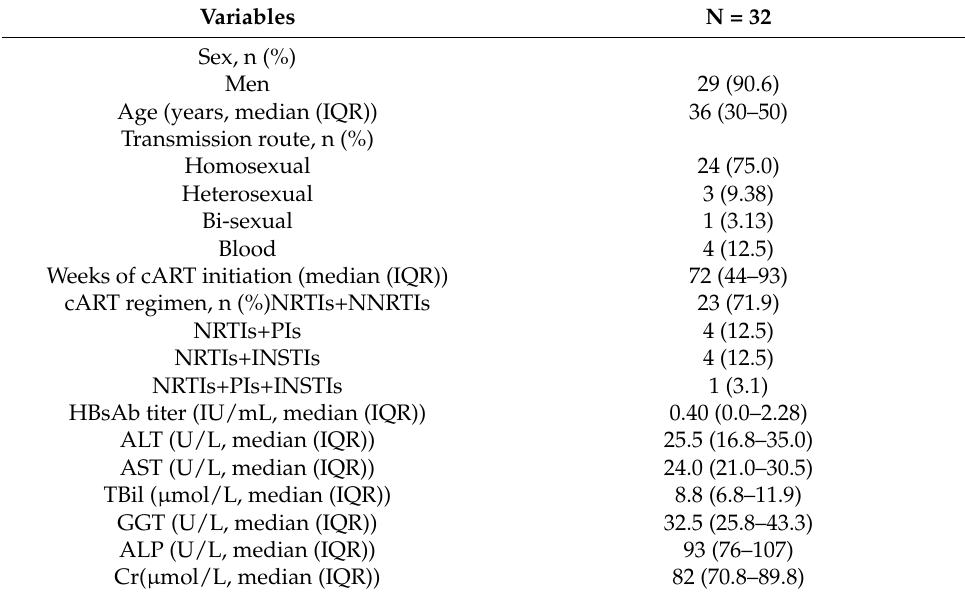
Table 1. Pre-vaccine characteristics of enrolled